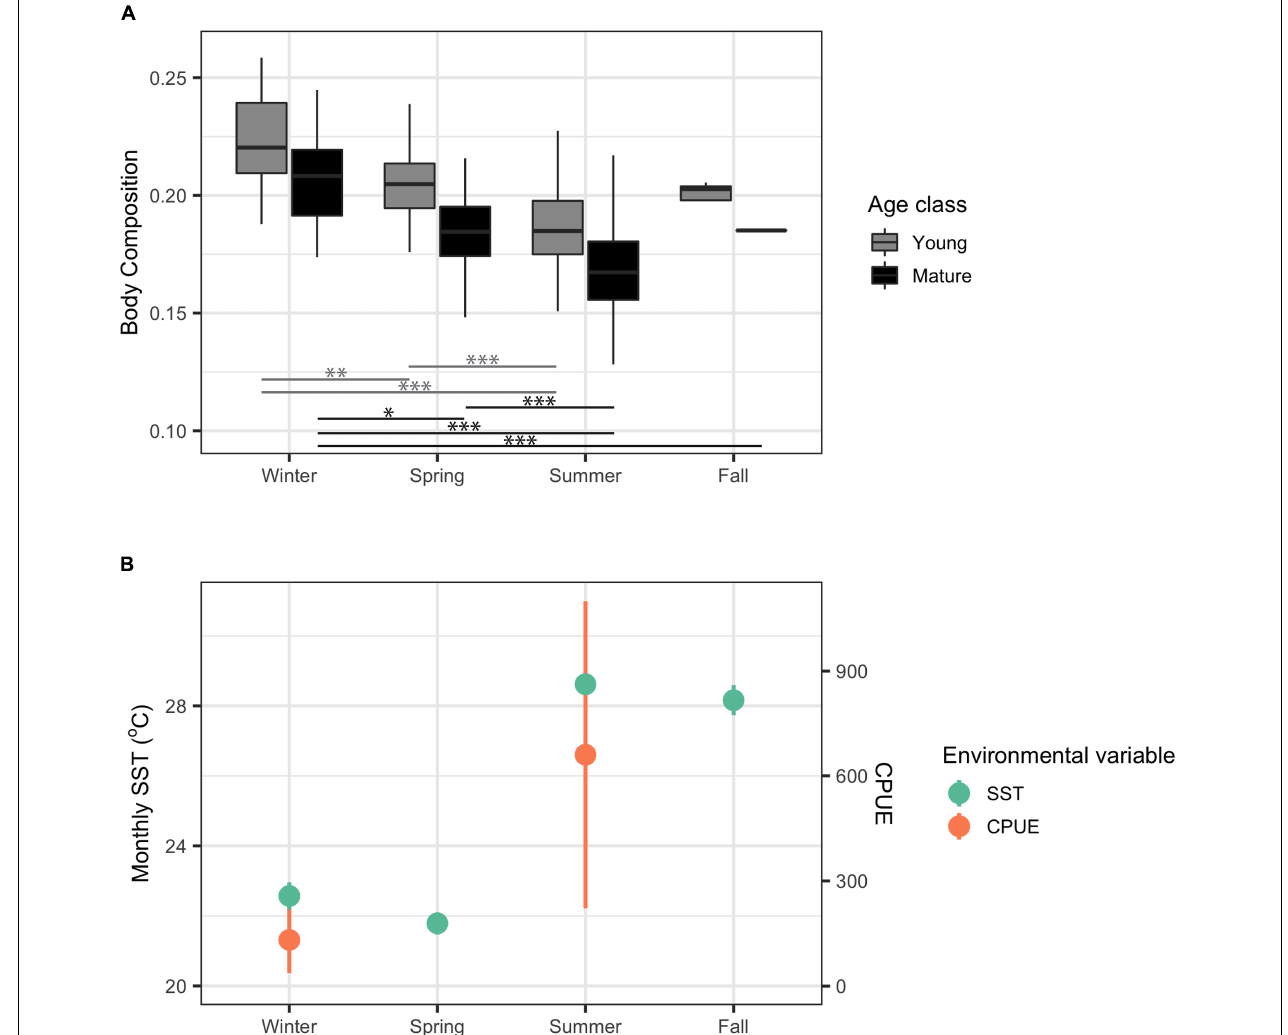
FIGURE 4 | Body composition for young and mature ( n = 254 and n = 280, respectively) common bottlenose dolphins ( Tursiops truncatus ) in Sarasota Bay by season from data collected from 1986 to 2016 (A) and monthly sea surface temperature (SST) and catch per unit effort (CPUE) in Sarasota Bay average by season during the years 1986–2016, 2003–2016, and 2006–2016, respectively (B) . Significance from Dunn test results are indicated by one asterisk ( p < 0.05), two asterisks ( p < 0.001), and three asterisks ( p < 0.0001). Monthly SST data were extracted from HadISST Average Sea Surface Temperature at 1 ◦ spatial resolution. CPUE data were collected from seine trawls in winter and spring in Sarasota